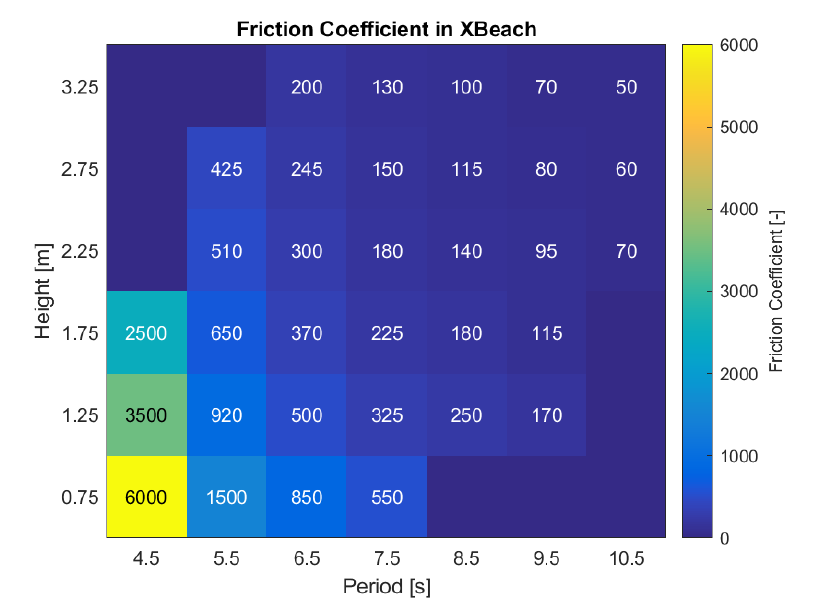
Figure 8. The friction coefficients ( f w ) calculated in XBeach corresponding to the period-averaged K t from WEC–Sim. The friction coefficient is selected due to the presence of one WEC in